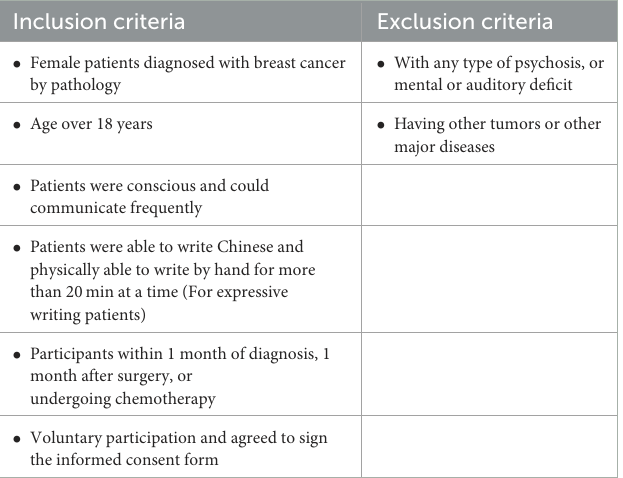
TABLE 1 Inclusion and exclusion criteria for patients included in the expressive writing and semi-structured interviews. Inclusion